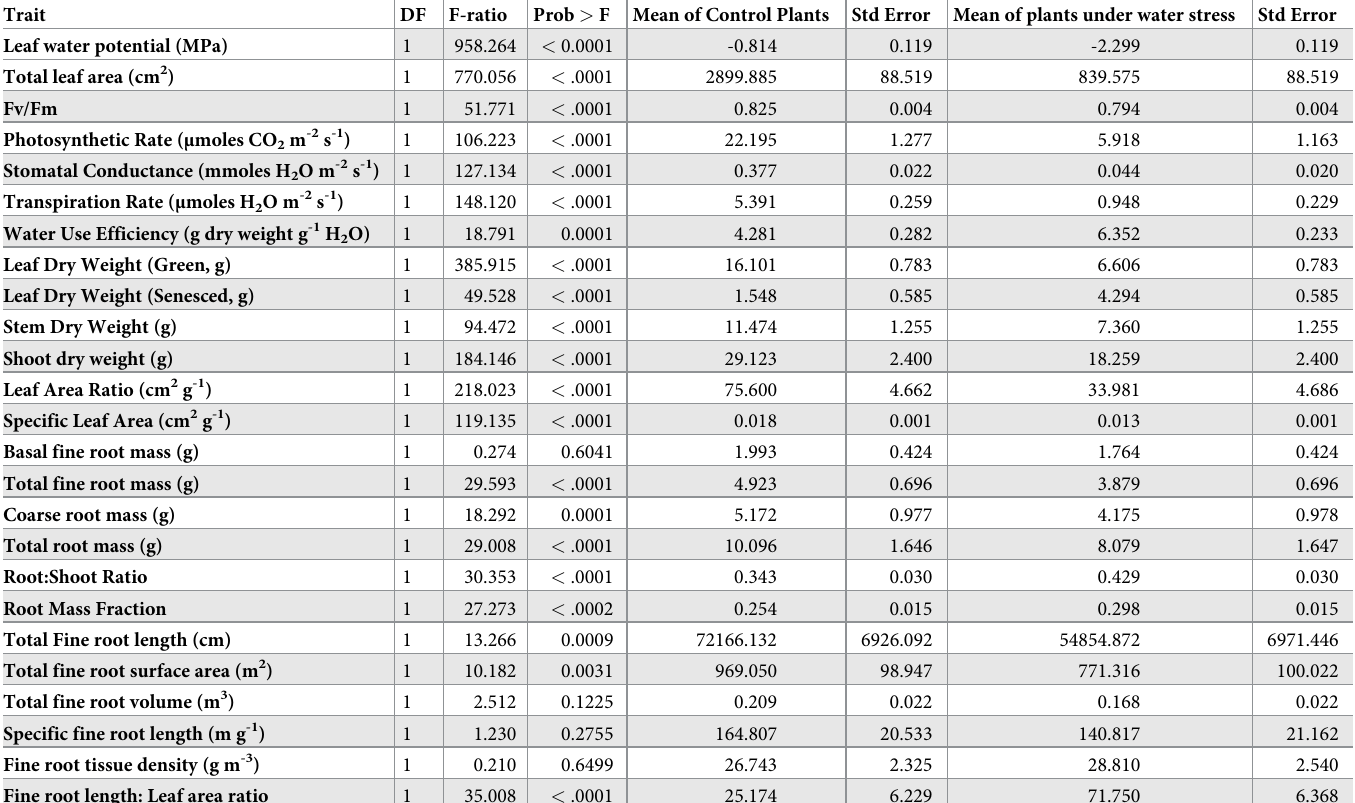
Table 1. Standard least squares analysis of physiological traits with Genotype as a random effect (REML method) during water stress phase.